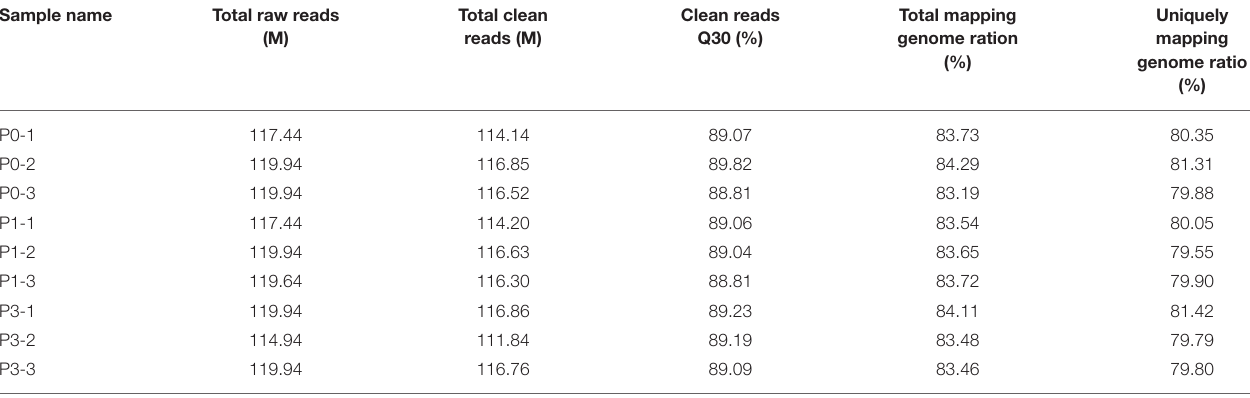
TABLE 2 | A summary of the alignment of sequencing reads to the oryctolagus cuniculus